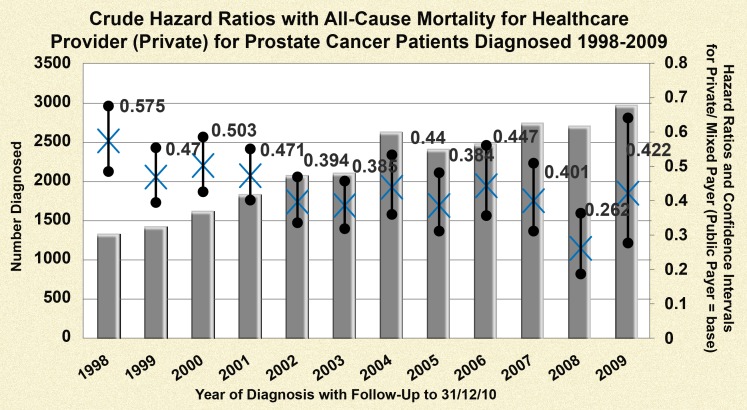
Crude hazard ratios for healthcare provider by year of diagnosis for men diagnosed with prostate cancer (1998–2009).
a. This graph contains 12 individual Cox PH models where the base category is ‘Public Payer’ for varying follow-up periods up to 31/12/10. b. All Hazard Ratios presented are statistically significant and confidence intervals are depicted by the line segments. c The test of proportional hazards (global test) revealed marginal non-proportionality for models with the following year of diagnosis: 1998, 2002, 2003, 2004; therefore caution is warranted in interpretation; however overall men with access to private healthcare had a lower risk of death than those who did not have access.